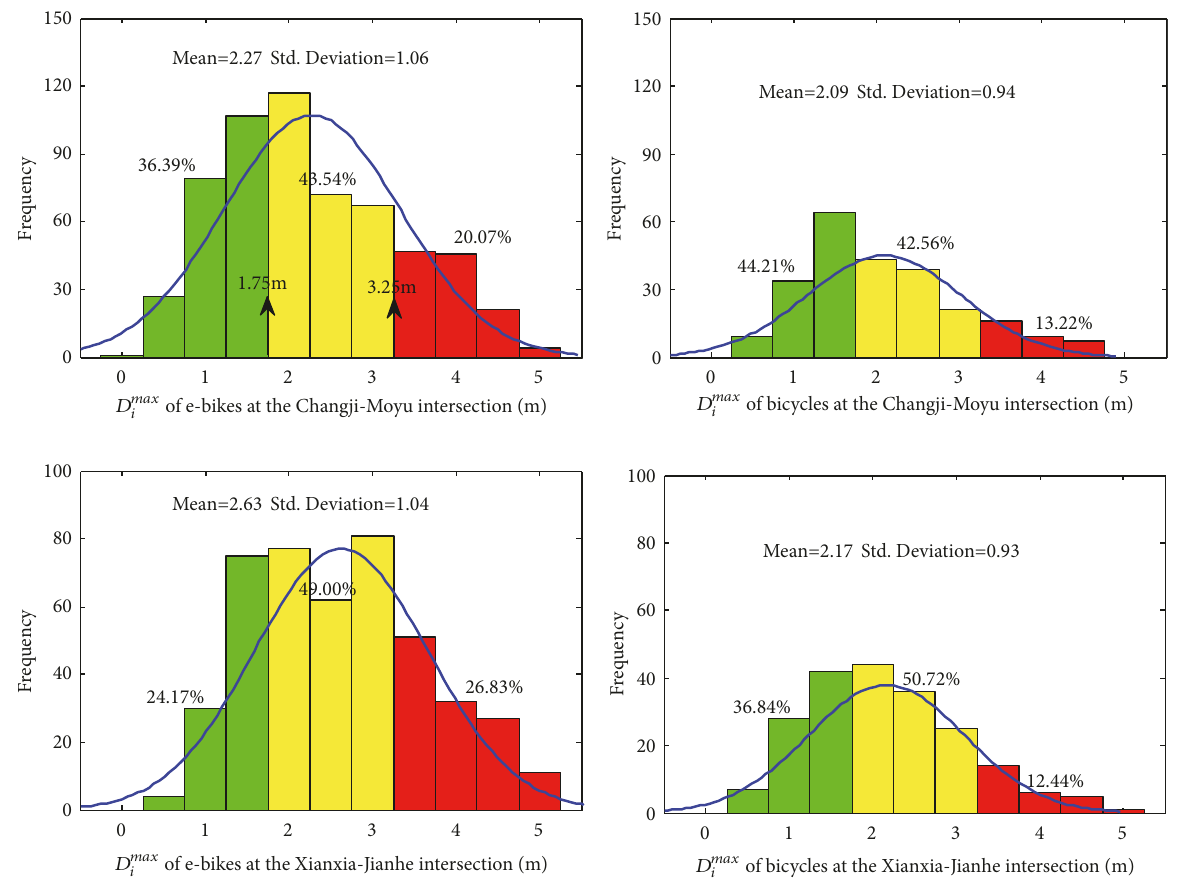
Figure 8: Histograms of 𝐷 𝑚𝑎𝑥 𝑖 for e-bikes and bicycles at both intersections.